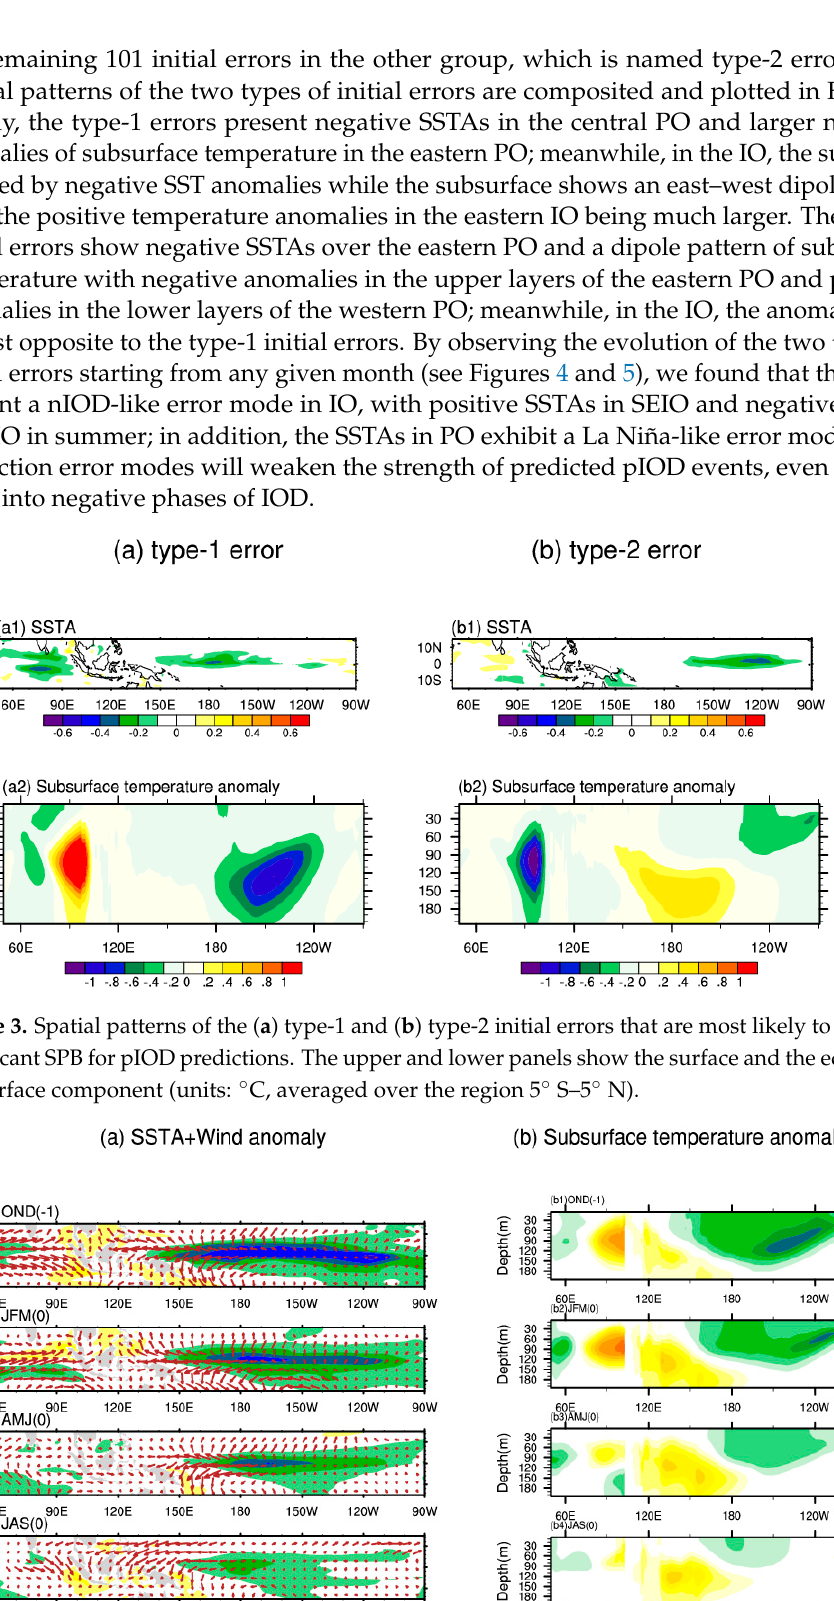
Figure 5. Same as Figure 4, but caused by the type-2 initial errors. We noticed that the PO components of the two types of initial errors were similar; furthermore, when we observed the evolutions of the two types of initial errors, they also behaved similarly. Specifically, due to the effect of negative SST errors in PO, anomalous easterlies are induced over the PO, which drive the sustainable northwesterly anomalies around the SEIO through the gear effect of double-cell Walker circulation. Such anoma- lous northwesterlies associated with SPB initial errors are greatly suppressed by climato- logical southeasterlies and anomalous southeasterlies induced by the pIOD event itself during summer, and then stimulated during the subsequent autumn and winter (Figure 6). Even the anomalous northwesterlies are also depressed in spring; the strength of the climatological and anomalous wind field are both weaker than in summer, which weak- ens the inhibition of wind anomalies induced by initial errors. Therefore, such seasonal modulation of climatological and IOD-induced wind on the anomalous wind associated